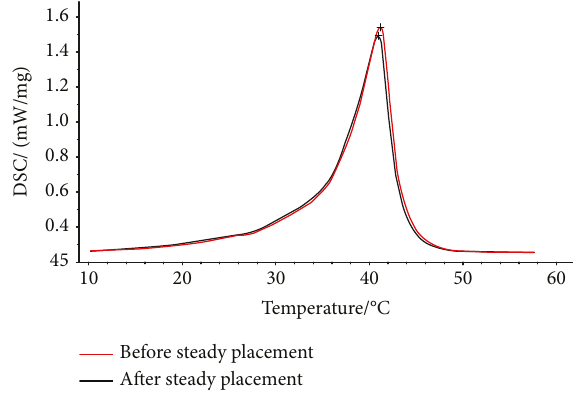
Before steady placement Figure 5: DSC curves of the 30% alkyl hydrocarbon PCS before and after ten months ’ steady